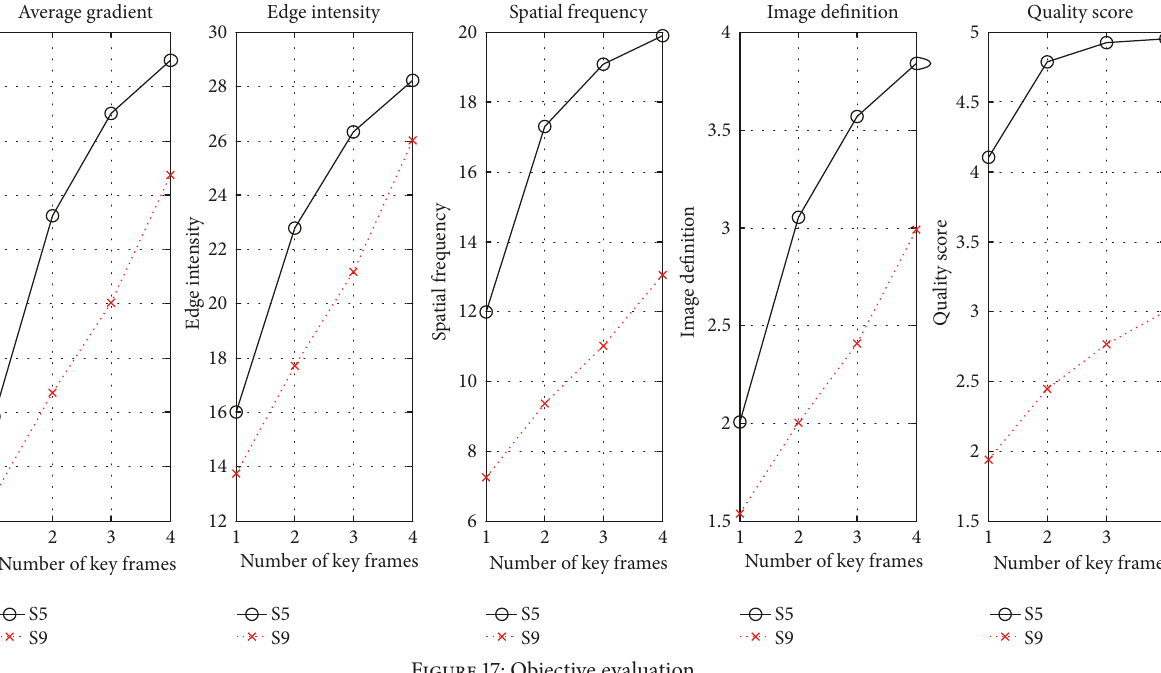
Figure 17: Objective evaluation.